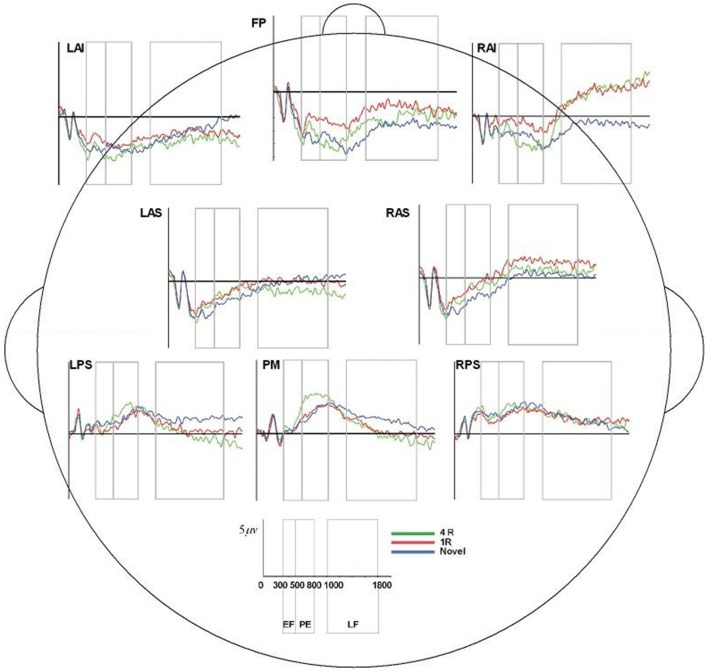
ERP, event-related potential; LAS, left anterior superior; FP, frontal pole; RAS, right anterior superior; LPS, left posterior superior; RPS, right posterior superior; PM, posterior medial; RAI, right anterior inferior; RAS, right anterior superior; 4R, presented 4 times; 1R, presented 1 time; N, Novel; EF, Early Frontal Effect, 300–500 ms; PE, Parietal Effect; 500–800 ms; LF, Late Frontal Effect; 1,000–1,800 ms. Average ERP wave forms for each region of interest (ROI) across the three conditions for processor B. X-axis represents time (in milliseconds) from 0 to 2,000, and Y-axis represents microvolts. Blue lines represent novel face-name (FN) pairs (correct rejections), red lines represent 1-time repeated (lR) FN pairs (hits), and green lines represent 4-times repeated (4R) FN pairs (hits).